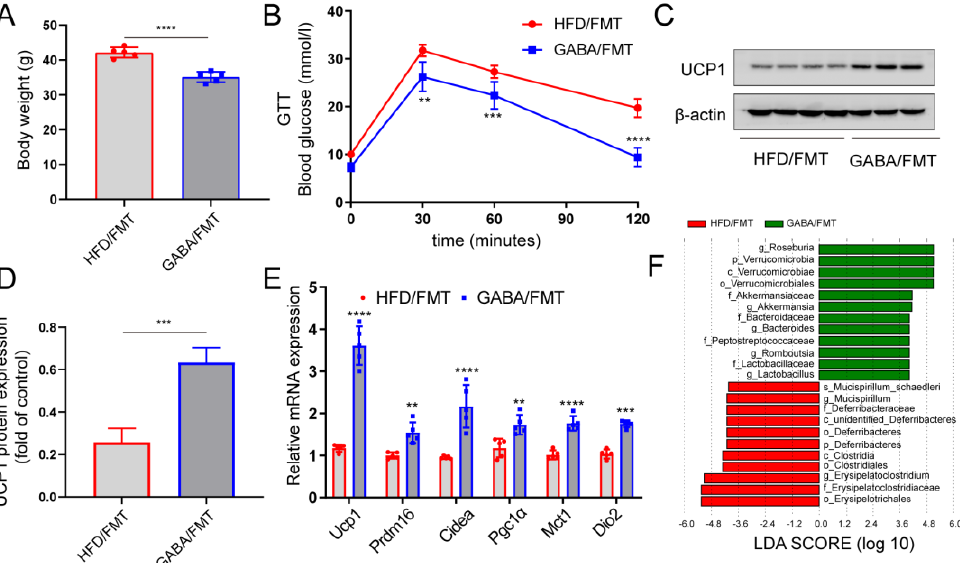
Figure 6. FMT is sufficient to induce the beiging of iWAT caused by GABA. Intestinal microbiota-free HFD-fed mice were colonized by fecal matter from either HFD-fed mice or GABA-treated mice for one week. ( A ) Body weight after the FMT experiment. ( B ) GTT curve of the HFD/FMT and GABA/FMT groups. ( C , D ) UCP1 protein expression in the iWAT was detected via immunoblot analysis. β-actin was used as the internal reference. ( E ) Relative mRNA expression of thermogenic genes in the HFD/FMT and GABA/FMT groups. ( F ) Histograms of LDA scores identifying taxa differentially represented between the HFD/FMT and GABA/FMT groups (LDA score > 2). Data are presented as mean ± standard deviation and were analyzed using a two-tailed Student’s t -test or two-way ANOVA. ** p < 0.01, *** p < 0.001 and **** p < 0.0001 compared to HFD/FMT group. ANOVA, analysis of variance; FMT, fecal microbiota transplantation; GABA, Gamma-aminobutyric acid; GTT, glucose tolerance test; HFD, high fat diet; iWAT inguinal white adipose tissue; LDA, linear discriminant analysis.